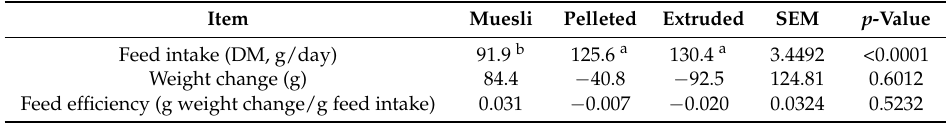
Table 2. Feed intake, weight change, and feed efficiency of rabbits fed the dietary treatments during the 30-day collection